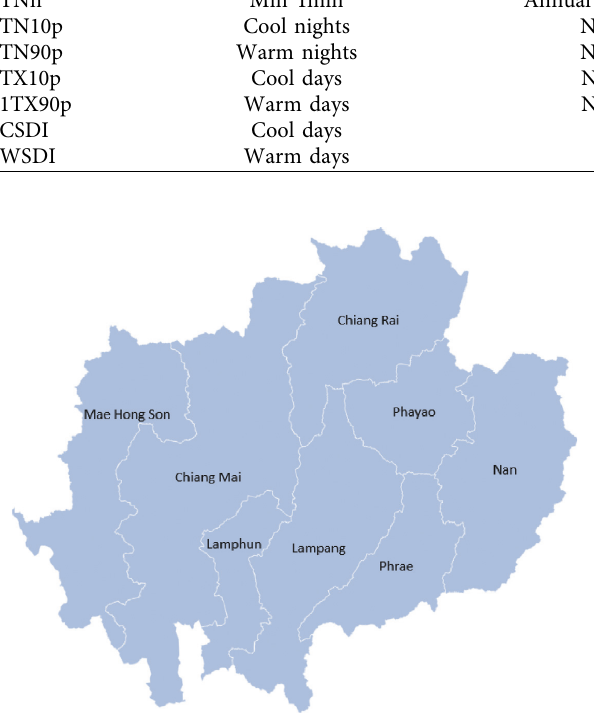
Figure 1: Northern